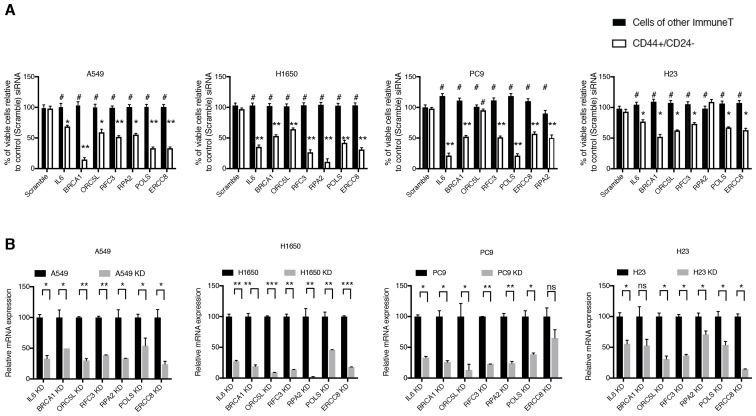
Validation of shRNA screen hits in tumor-derived cell lines FACS sorted on the basis of the surface expression of CD44 and CD24.( A) The charts represent the percentage of viable CD44+/CD24− cells and cells of other immune types upon transfection with the indicated siRNA oligonucleotides relative to control (scramble siRNA). Each bar represents mean ± SD of three technical replicates from two independent experiments. 10,000 cells were analyzed by FACS for each replicate of each sample. (B) Efficiency of knockdown upon transfection with the indicated siRNA oligonucleotides and compared to control cells transfected with scramble siRNA. Cells were collected 3 days post transfection and analyzed for expression of the indicated mRNA. Each bar represents mean ± SD of three replicates. p-value *<0.05, **<0.005, ***<0.0005, unpaired t-test. Non-significant differences are shown by the symbol ‘#’ or ‘ns’.